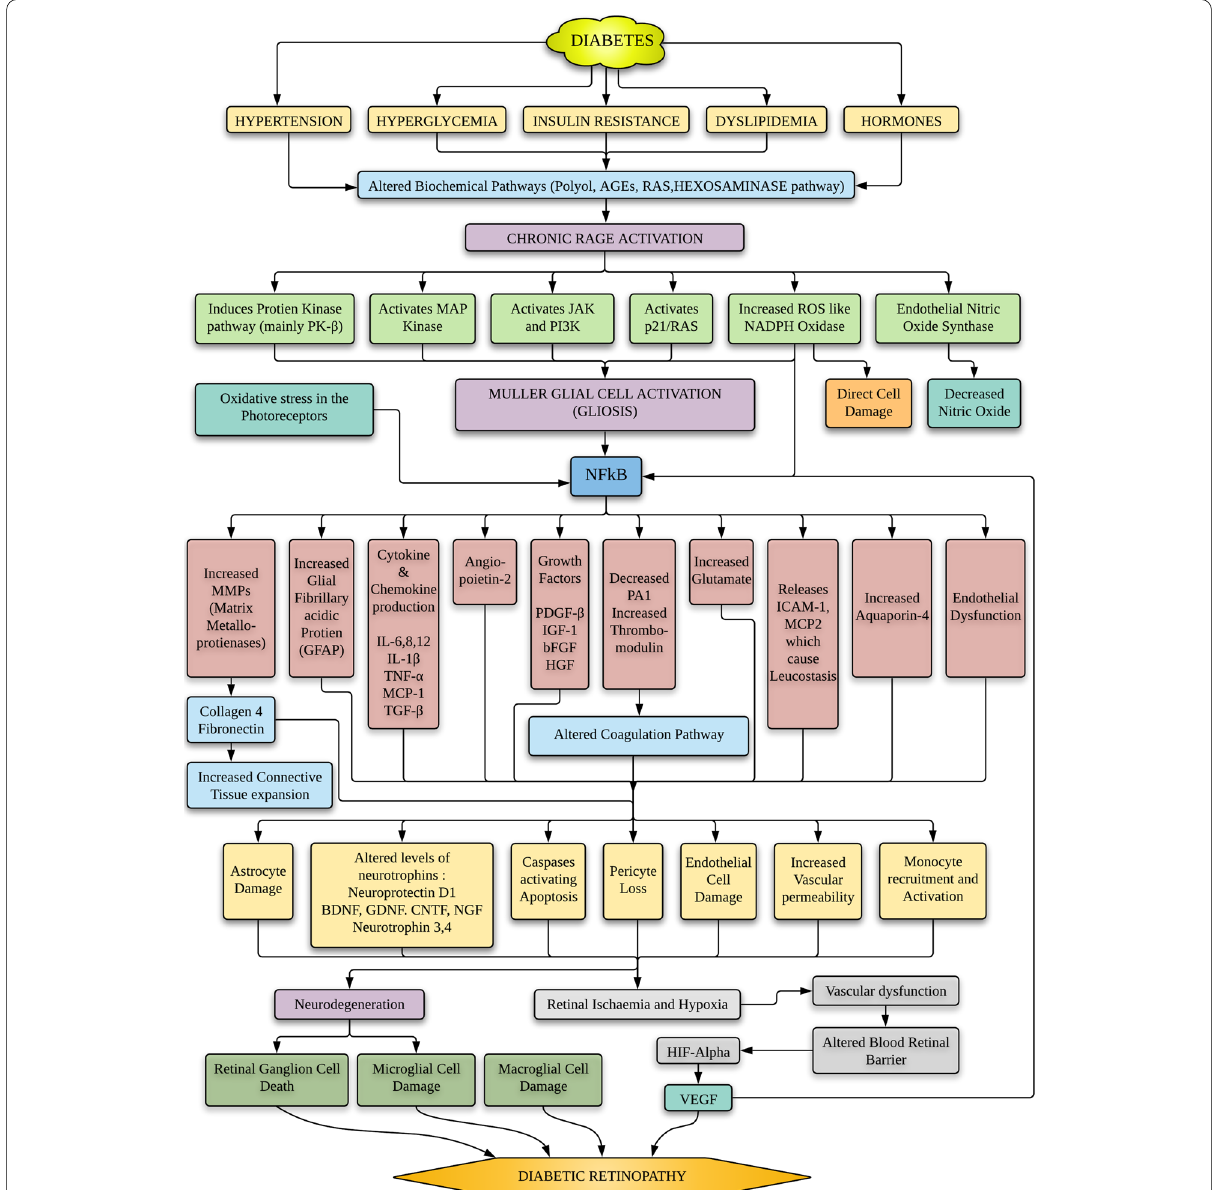
Fig. 4 Downstream cascade of various chemokines, cytokines, and inflammatory mediators that causes damage to various retinal cells causing diabetic